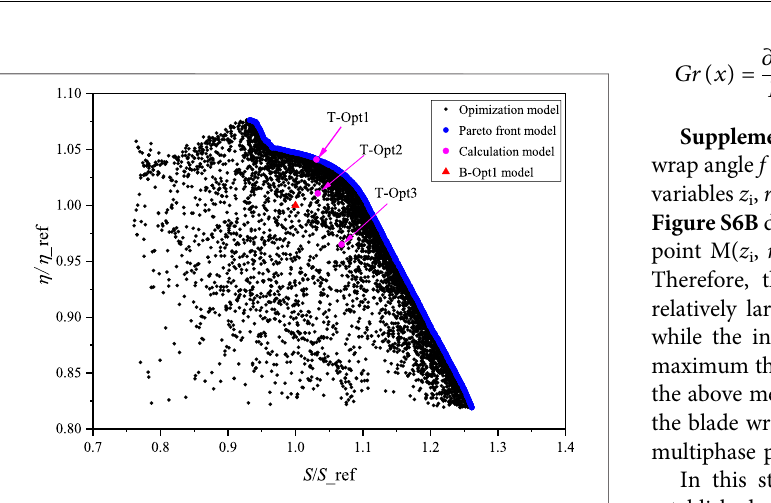
FIGURE 11 | Pareto results of impeller loading